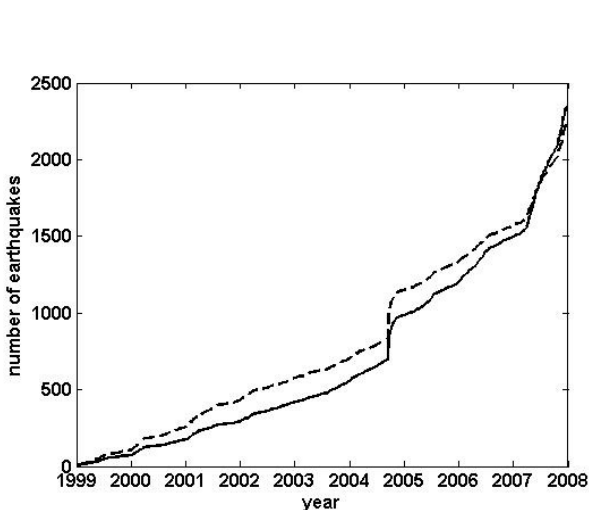
Fig. 2. In solid line, the real seismicity, and in dashed line, the ETAS model.